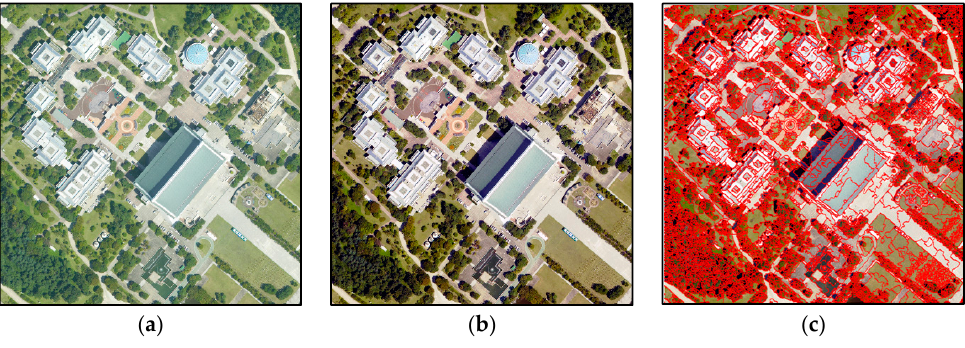
Figure 2. Image segmentation: ( a ) original image; ( b ) radiometric-enhanced image; and ( c ) segmented image (red lines are segment boundaries).